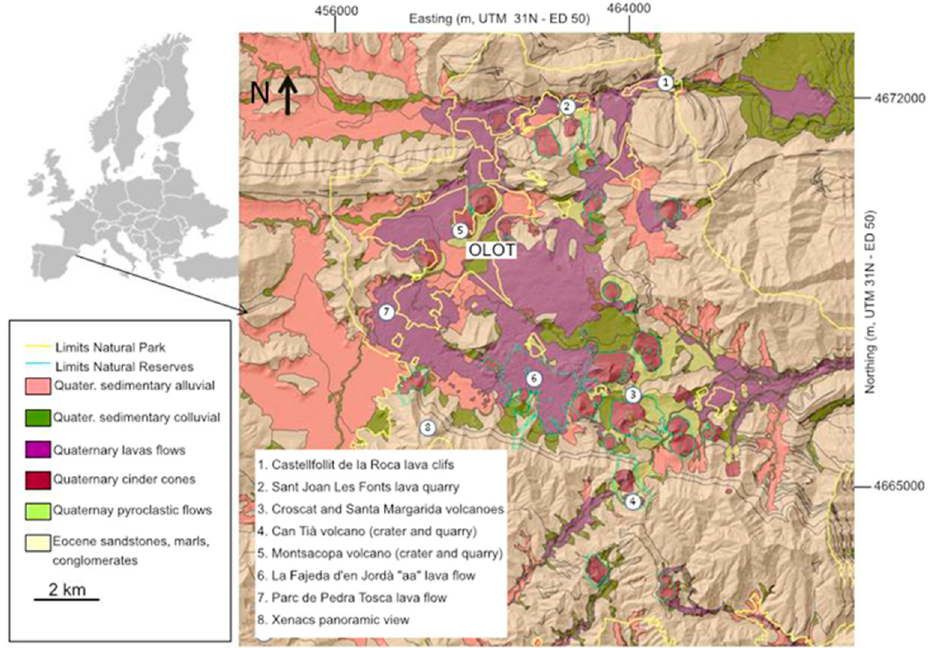
Figure 1. Simplified geological scheme of La Garrotxa Volcanic Zone with indication of the borders of the natural park and the nature reserves and places of geological, natural, and cultural interest.